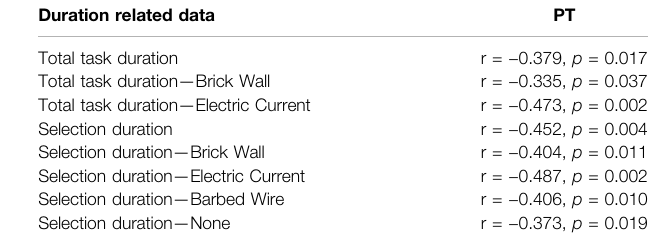
TABLE 3 | PT is negatively correlated with the task completion